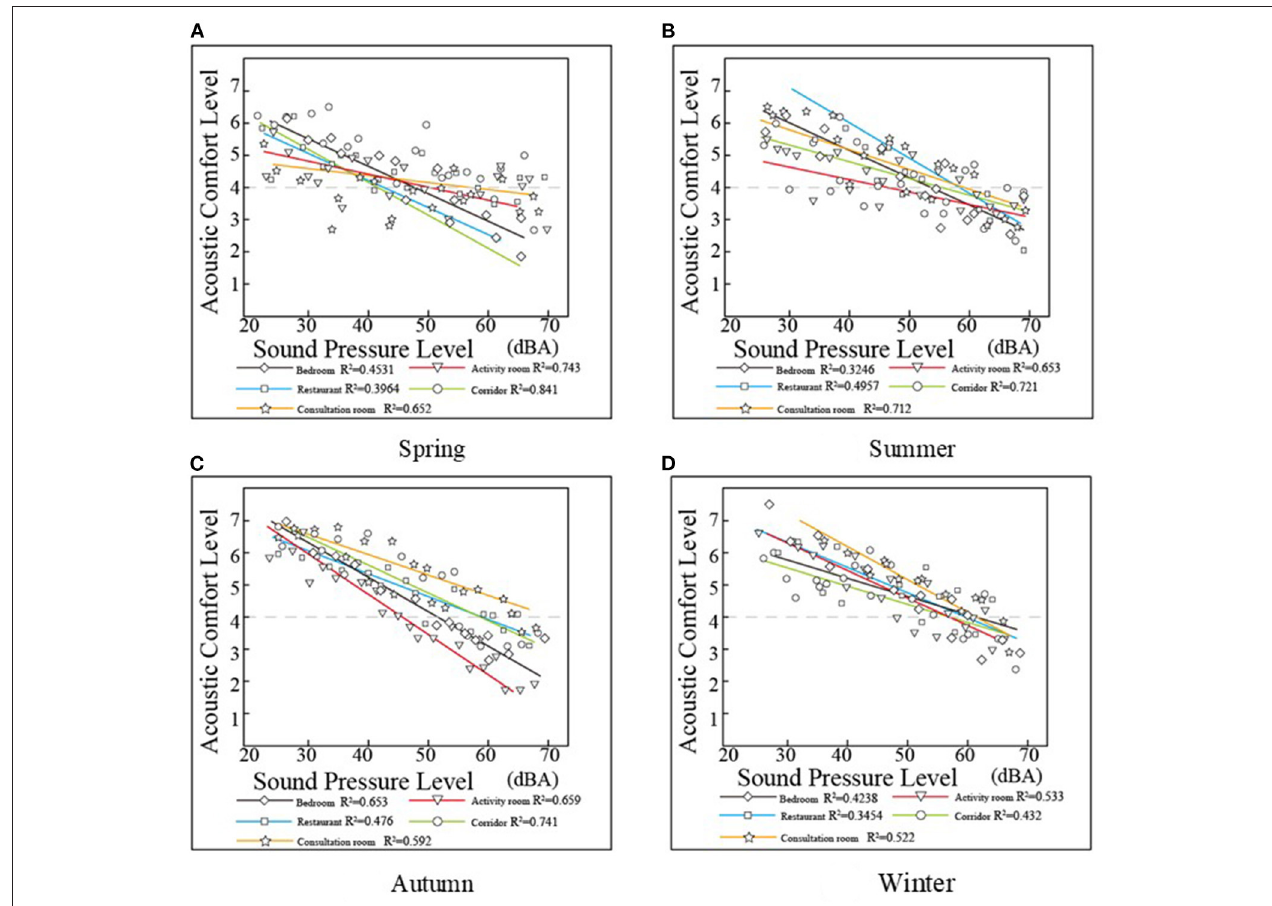
FIGURE 4 | Fitting between SPL and acoustic evaluation based on seasonal differences. (A) Spring, (B) Summer, (C) Autumn, and (D)